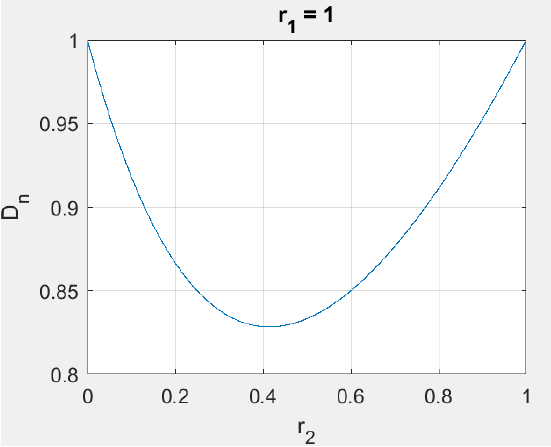
Figure 6. The Null Point location as a function of the distance of the movable body from the pivot.